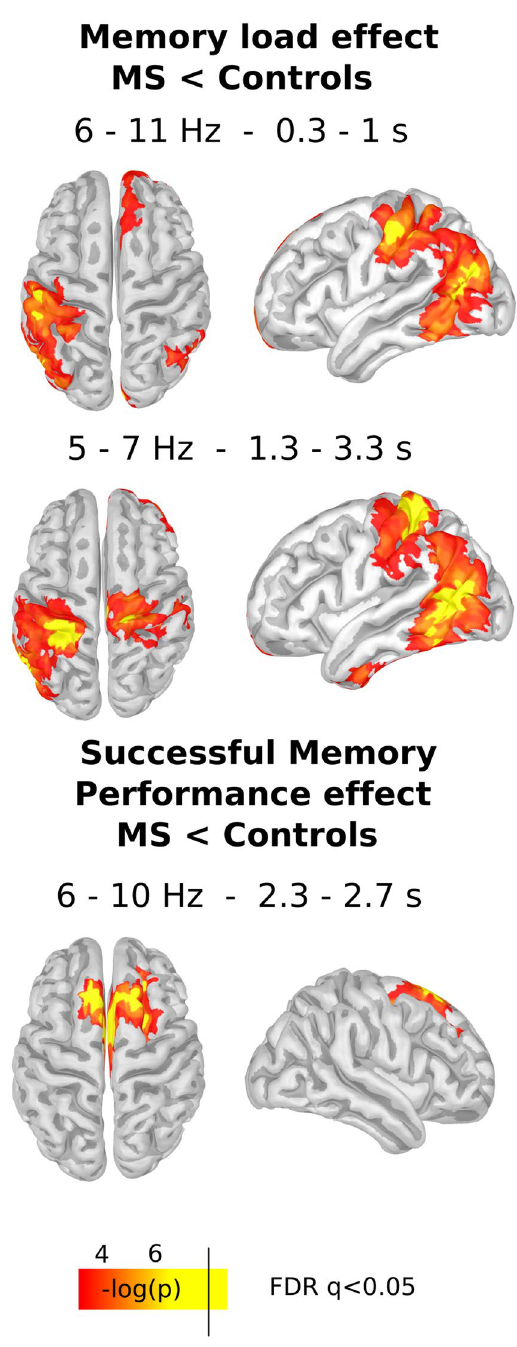
Figure 5. Source reconstruction of the differences between groups. The upper panel shows the differences in the memory load modulation in theta activity during encoding as is highlighted in I. The middle panel shows the differences in the memory load modulation in theta activity during maintenance as is highlighted in Fig. 3 M. The top panel shows the differences in the modulation in theta activity related to Successful Memory Performance (SMP) during maintenance as is highlighted in Fig. 4 C. Only significant clusters (p < 0.05 cluster corrected), and vertexes that survive vertex-based correction are shown in yellow (FDR <